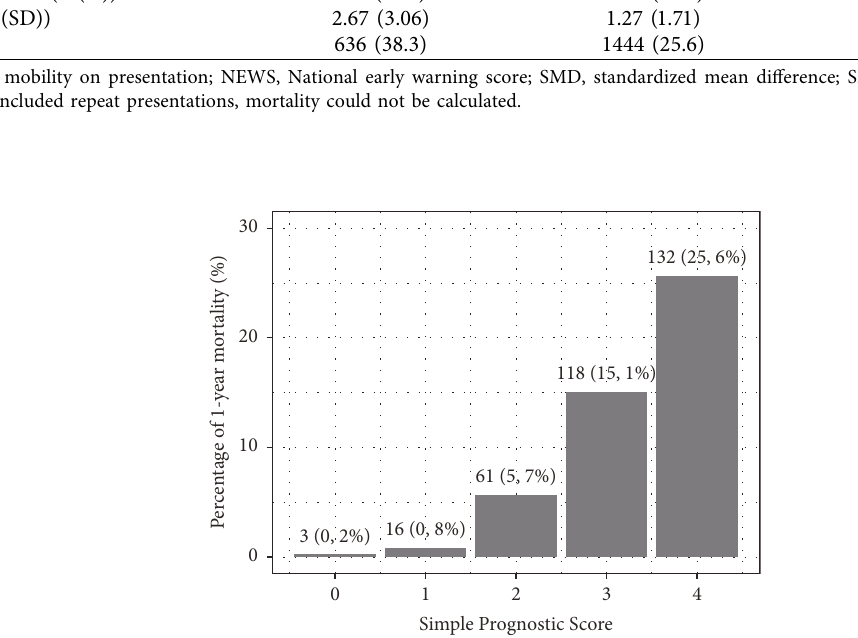
Figure 2:1-year mortality rate for each point of the Simple Prognostic Score (SPS). This figure shows the percentage of 1-year mortality for each point of the SPS.